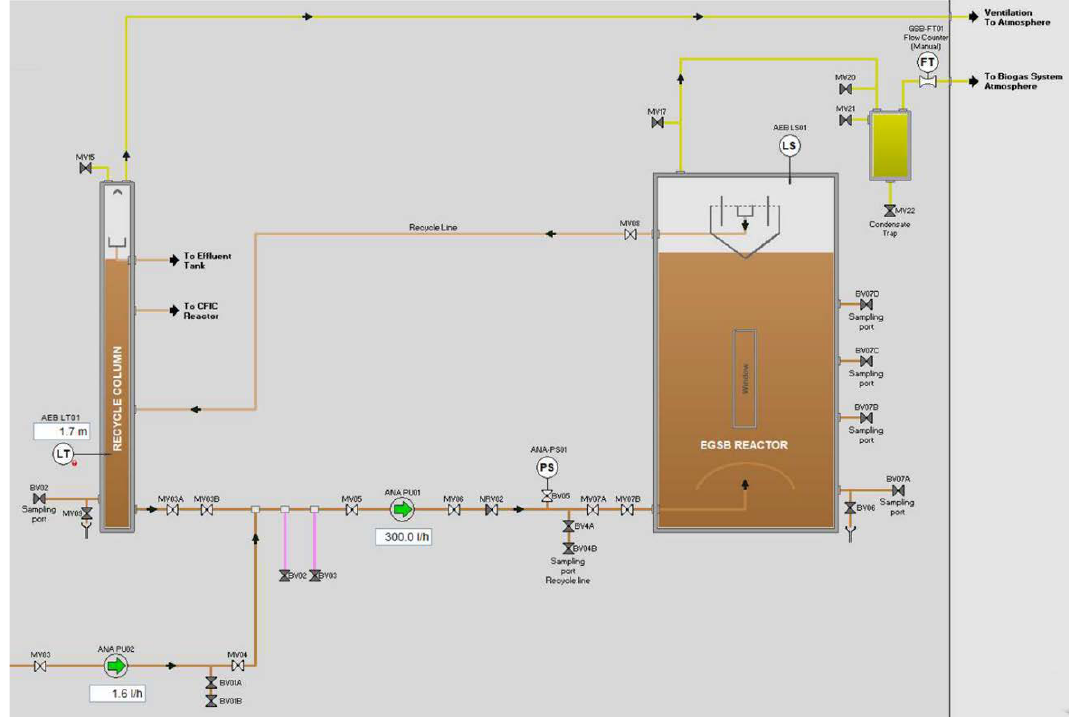
Figure 3. EGSB Reactor control and